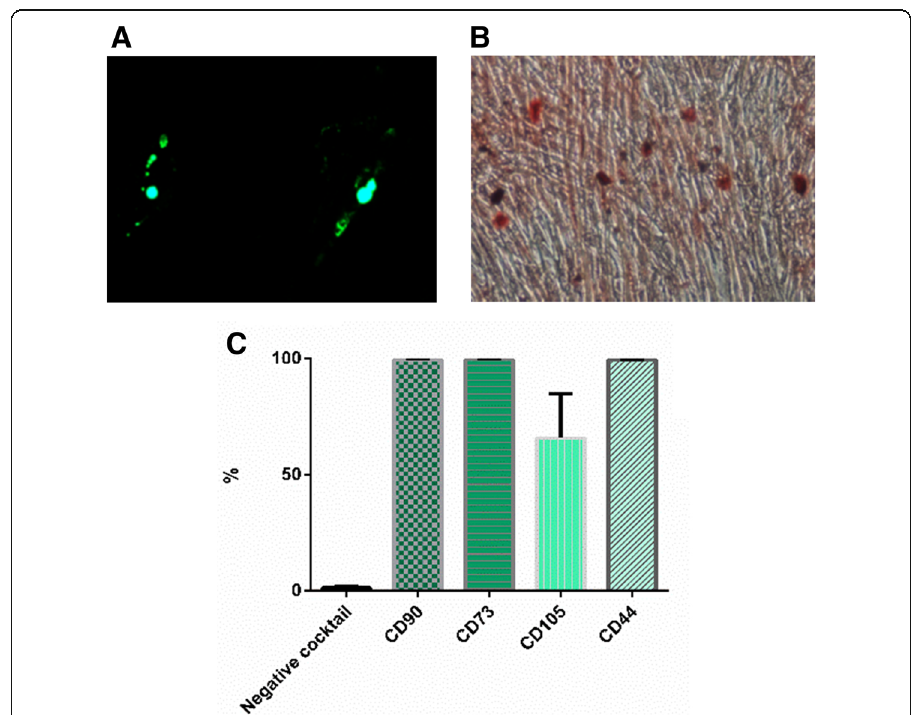
Fig. 1 Characterization of UCMSCs. Mesodermic differentiation of UCMSCs. Clinical-grade UCMSCs differentiated into adipocytes ( a ) and osteocytes ( b ). Representative images are shown at ×10 magnification. Immunophenotypic analysis of UCMSCs by flow cytometry ( c ). UCMSCs presented the typical immunophenotype of MSCs. Negative cocktail includes CD34, CD45, CD11b, CD19, and HLA-DR markers. Results are shown as percentages of positive cells and are expressed as mean±SEM. ( n